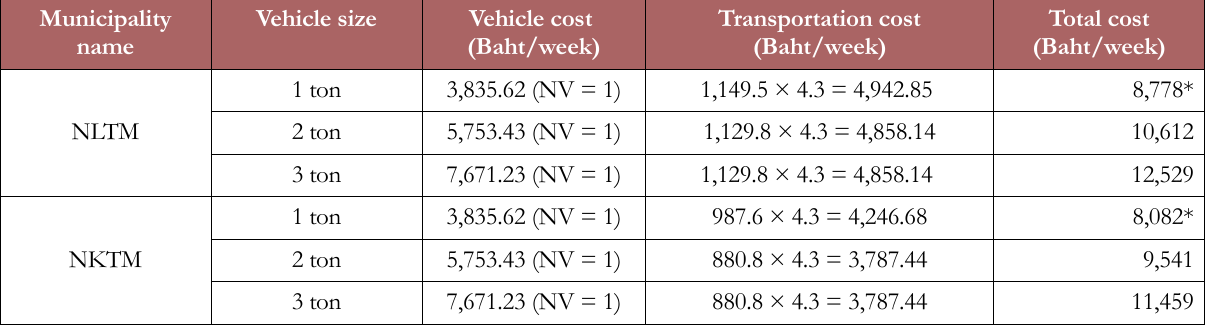
Table 11. Details of costs for choosing each vehicle